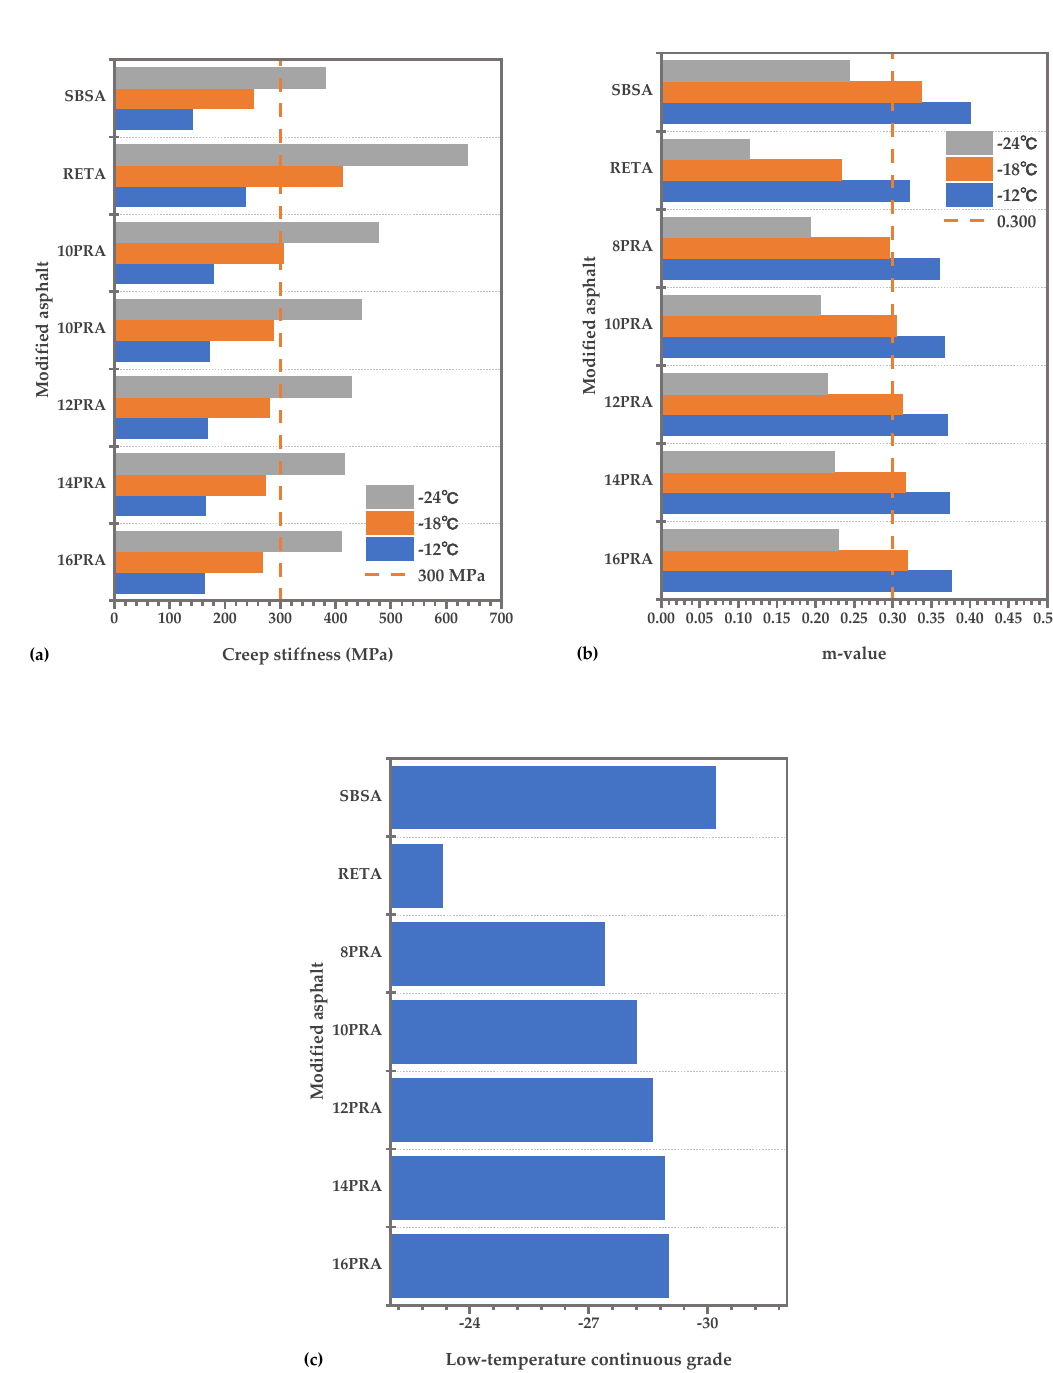
Figure 4. BBR test results of modified asphalts: ( a ) creep stiffness, ( b ) m-value, ( c ) low-temperature continuous grade.